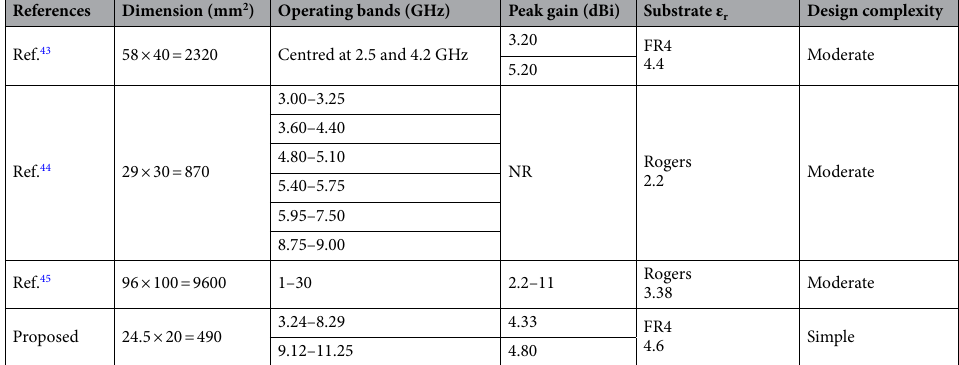
Table 2. Comparison of the proposed antenna with recently reported multi-band